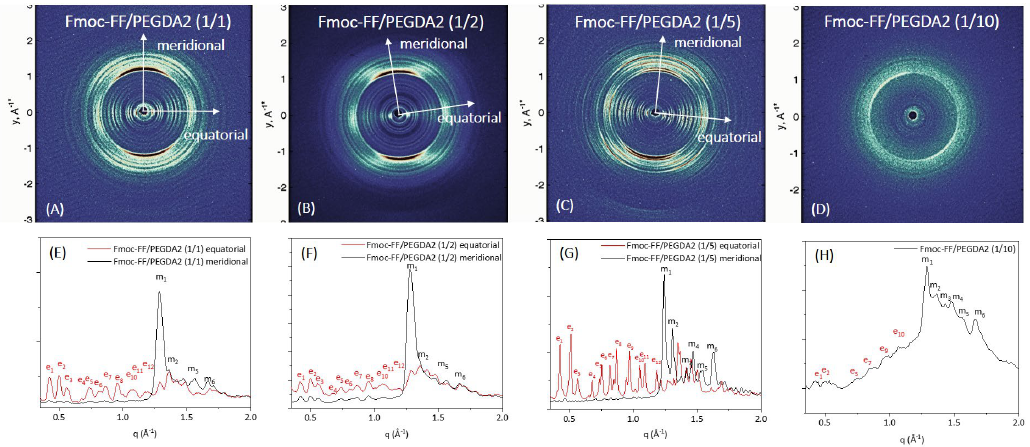
Figure 8. WAXS characterization of the mixed hydrogels Fmoc-FF/PEGDA2 at different concentra- tions: 2D WAXS data (on the top row right) and 1D WAXS meridional (black line)/equatorial (red line) (on the bottom row).